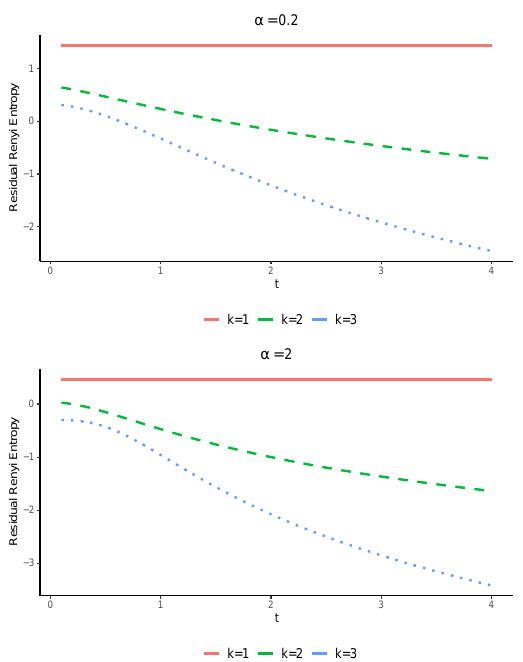
Figure 1. The exact values of H α ( T t 1,5 ) with respect to t for the Weibull distribution for values of α = 0.2 and α = 2 when 0 < k < 1.